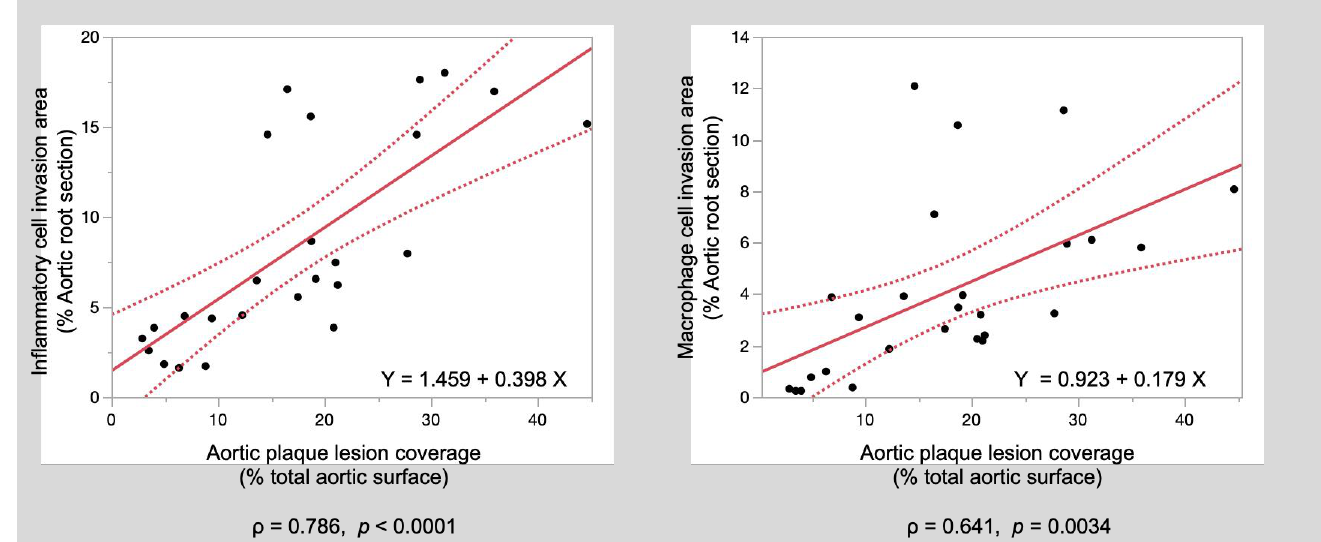
Figure 4. Correlation coefficient scatter diagrams. The aortic plaque lesion coverage ratio was significantly associated with the inflammatory cell invasion area ratio and macrophage cell invasion area ratio at the aortic root.